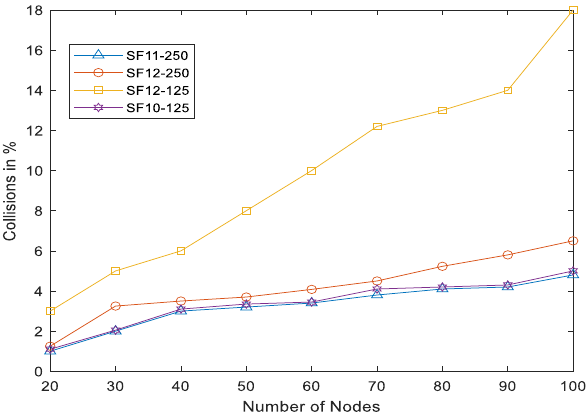
Figure 2: Percentage of collisions for di ff erent combinations of SF and bandwidth.